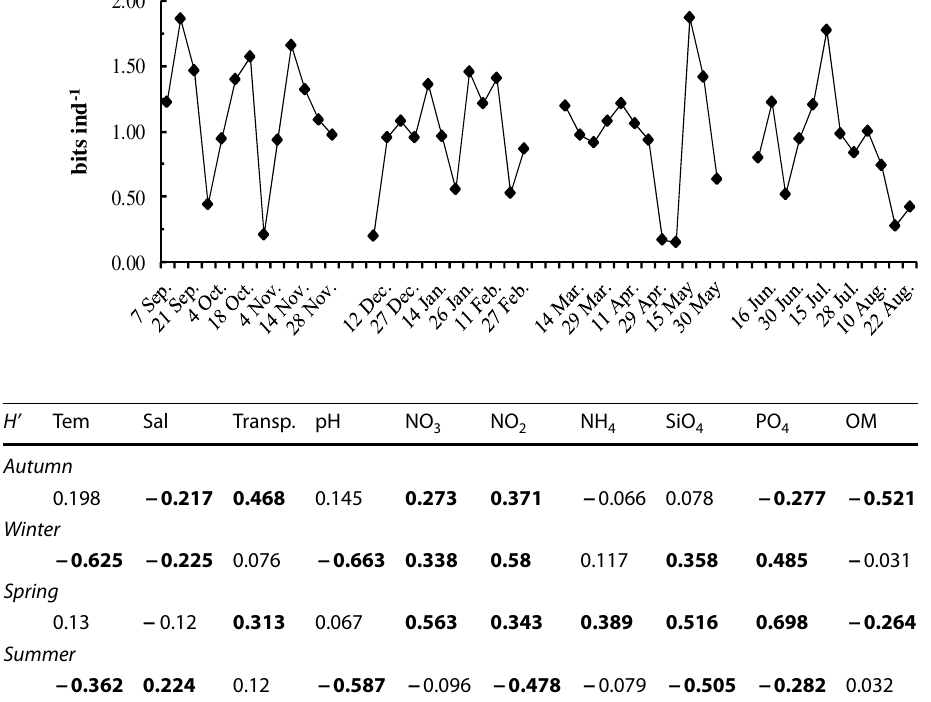
(Significant at P < 0.05 in Bold)